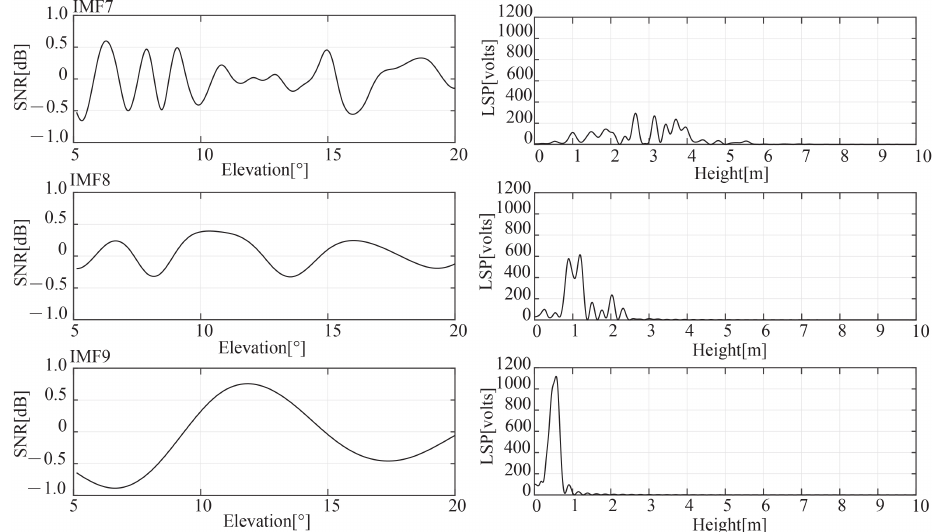
Figure 10. The EMD decomposition result and original SNR of GPS PRN2 when corn is above the GNSS antenna.